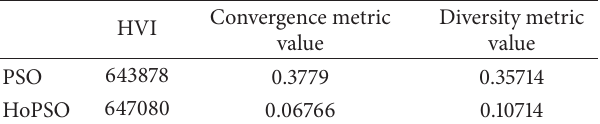
Table 6: The HVI, convergence, and diversity values produced by CPSO.